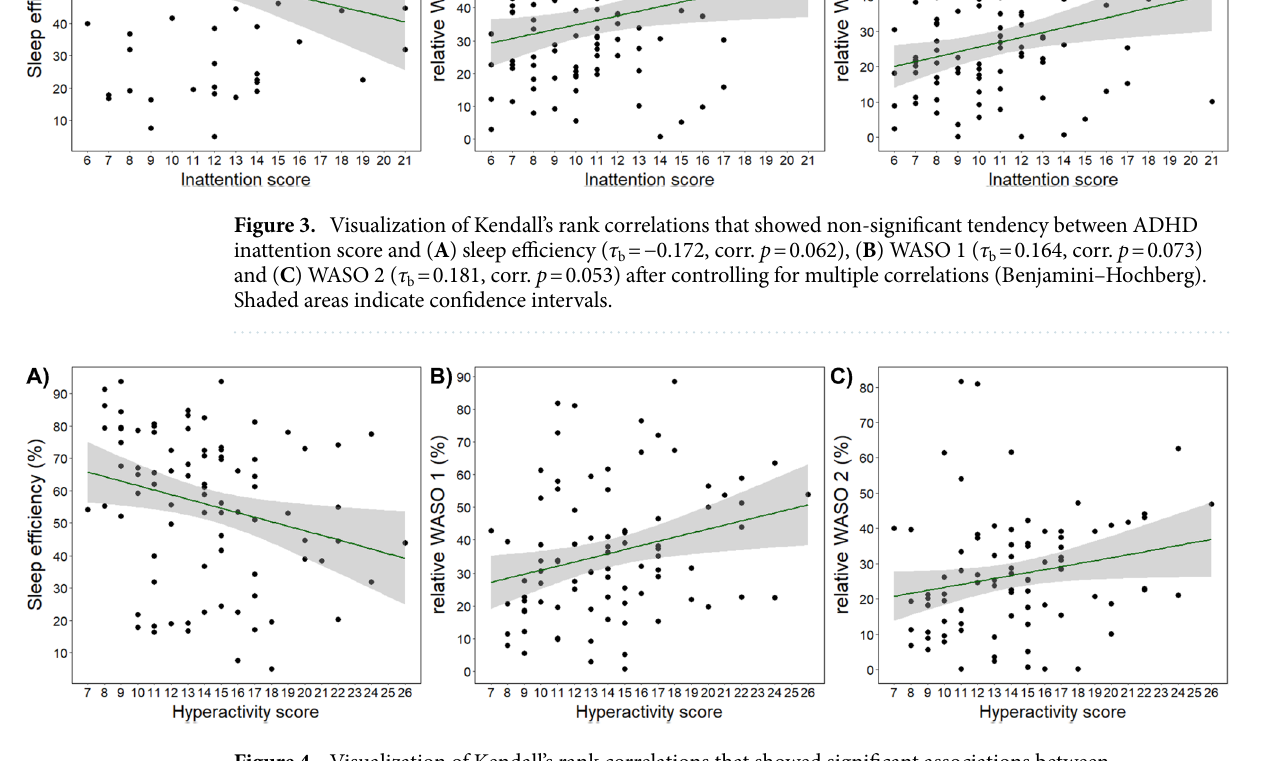
Figure 4. Visualization of Kendall’s rank correlations that showed significant associations between ADHD hyperactivity/impulsivity score and ( A ) sleep efficiency ( τ b = −0.208, corr. p = 0.031), ( B ) WASO 1 ( τ b = 0.198, corr. p = 0.031) and ( C ) WASO 2 ( τ b = 0.203, corr. p = 0.031) after controlling for multiple correlations (Benjamini–Hochberg). Shaded areas indicate confidence